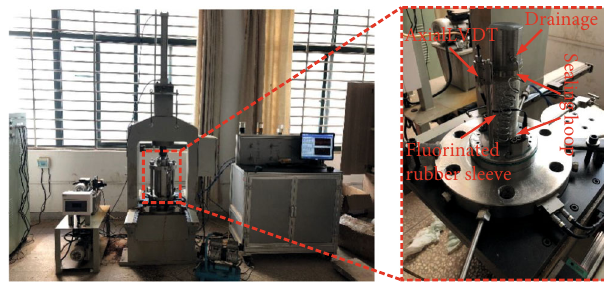
Figure 2: Multi fi eld coupled rock triaxial test system of